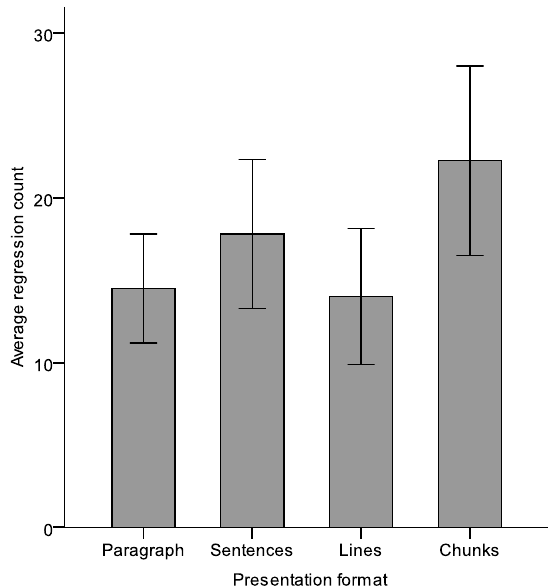
Figure 5: Box plot representing subjective